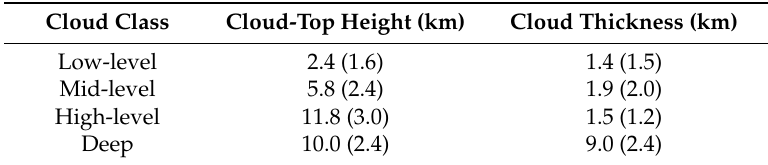
Table 1. Mean cloud-top height (km above ground level, or AGL) and cloud thickness for low-level, mid-level, high-level, and deep clouds. The standard deviation of the mean is given in parenthesis.